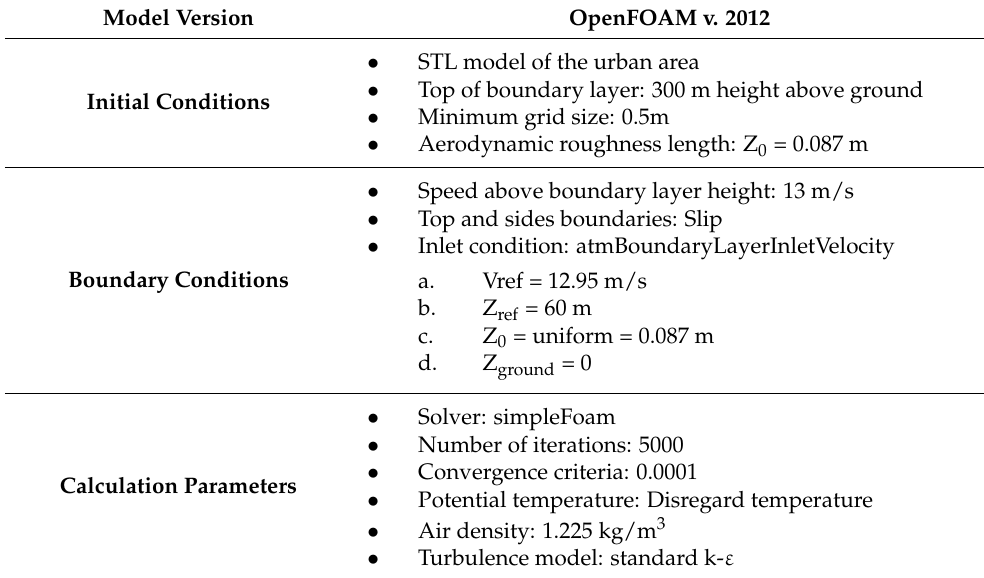
Table 3. Initial and boundary conditions imposed for the OpenFOAM model.